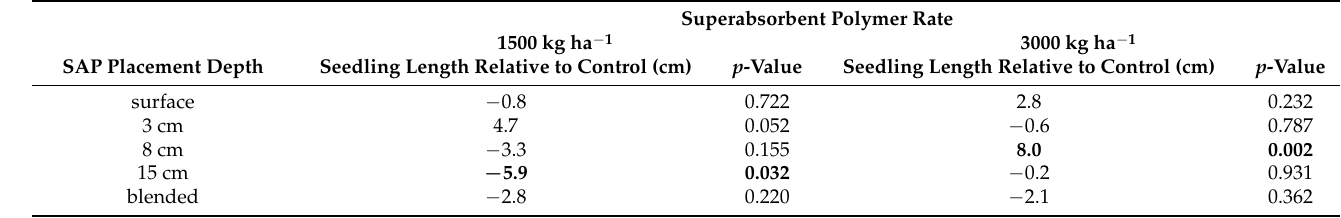
Table 4. Bottlebrush squirreltail seedling length, relative to an untreated control, as a function of superabsorbent polymer (SAP) rate and placement for a glasshouse study. The SAP (1500 or 3000 kg ha − 1 ) was blended with the soil to a depth of 15 cm or placed in a band at the surface or at 3, 8, or 15 cm deep directly below the seed; the soil was saturated and allowed to dry down. Bolded lengths are significant.